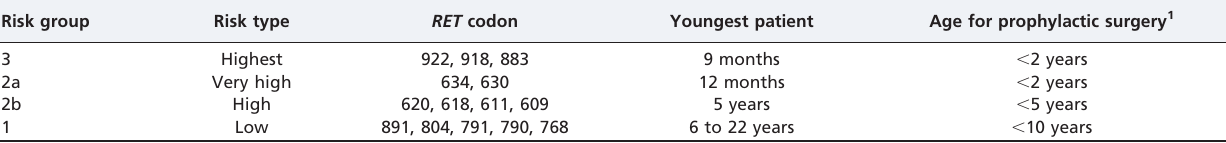
Table 1 - Risk stratification in MEN